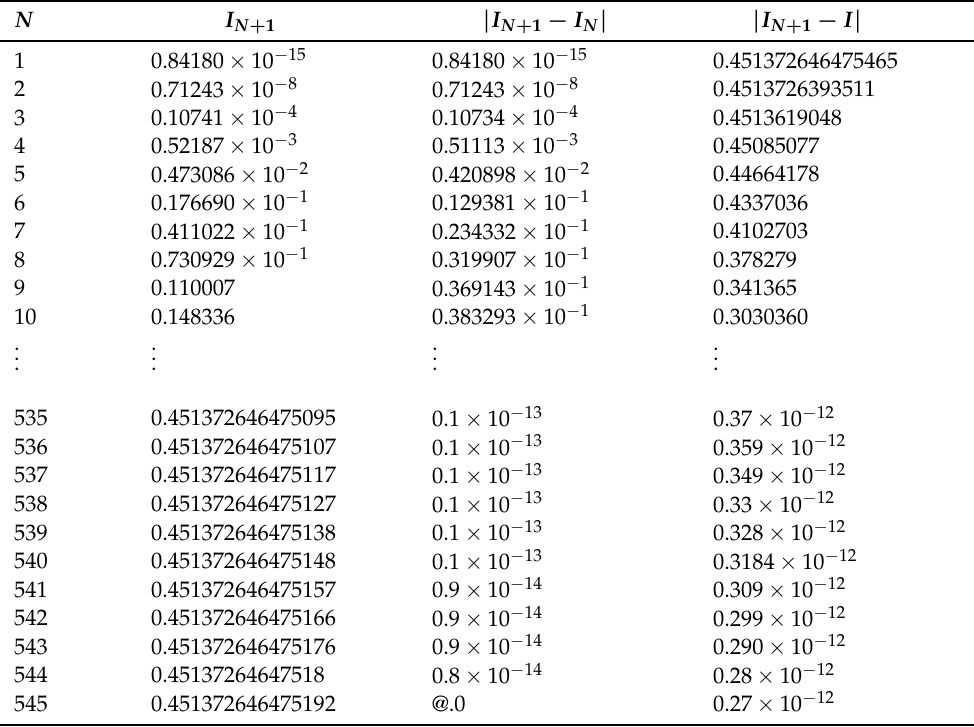
Table 5. The numerical results of the SE-Sinc integration rule to approximate the RO system based on the stochastic arithmetic (SA) and the CESTAC method using the CADNA library.